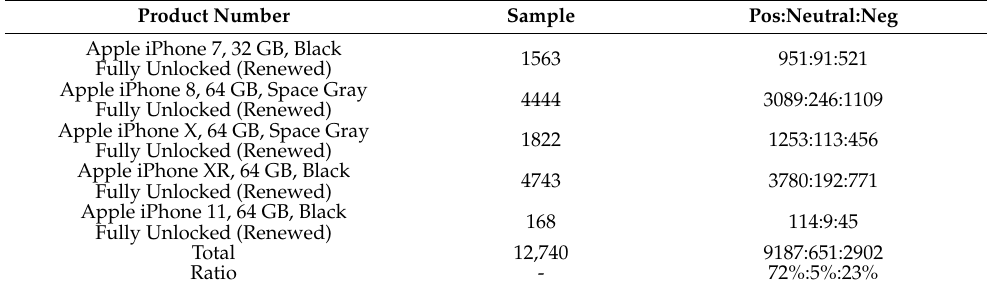
Table 3. Lifelong fine-grained product review sentiment classification Amazon (LFSC-A) dataset.